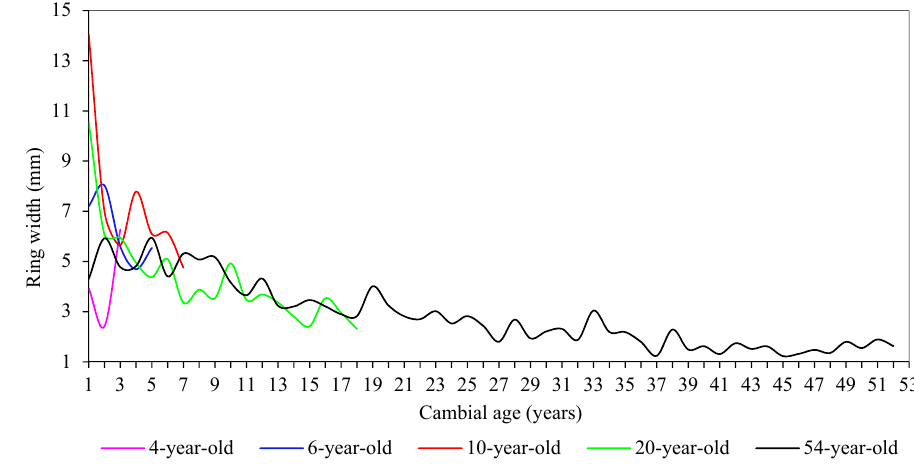
Figure 2. The radial variation of annual ring width versus cambial age of S. superba.